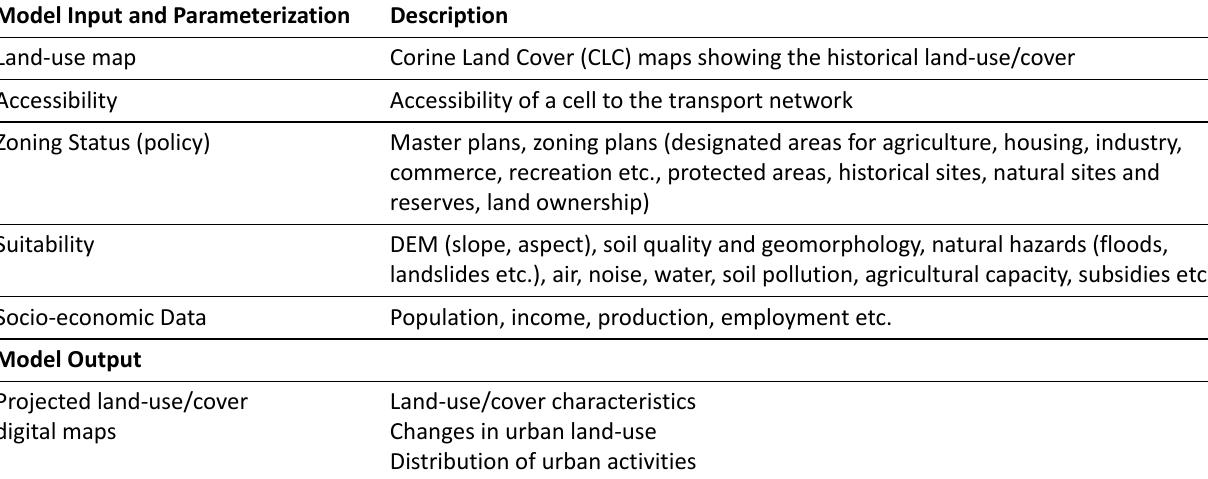
Table 1. Summary of the MOLAND Model: inputs and outputs.